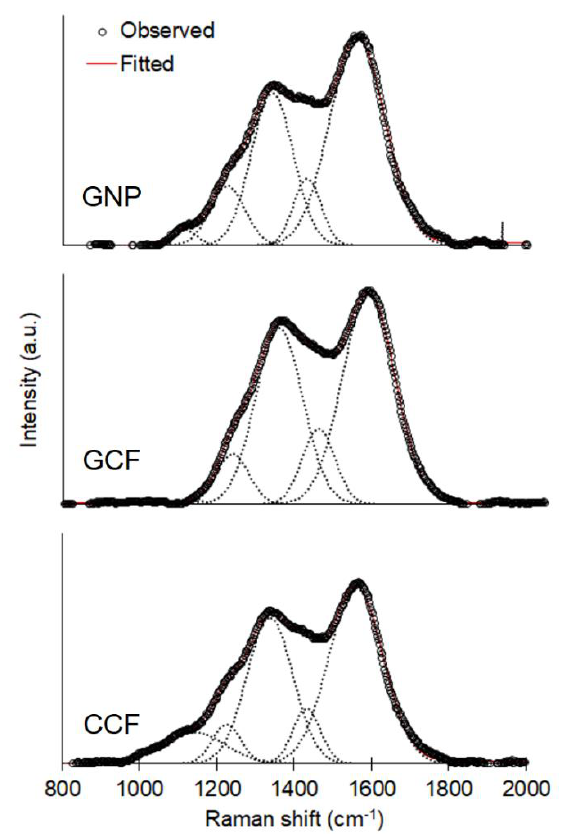
Figure 9. Raman spectra of GNP, GCF, and CCF. Table 1. Position, FWHM, and I / I Total of peaks after deconvolution of Raman spectra.